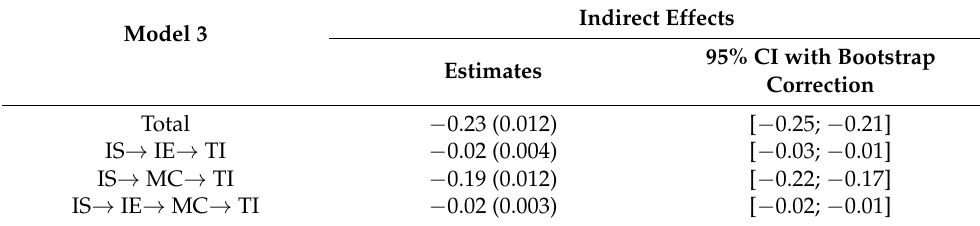
Table 7. Indirect effects of model 3.